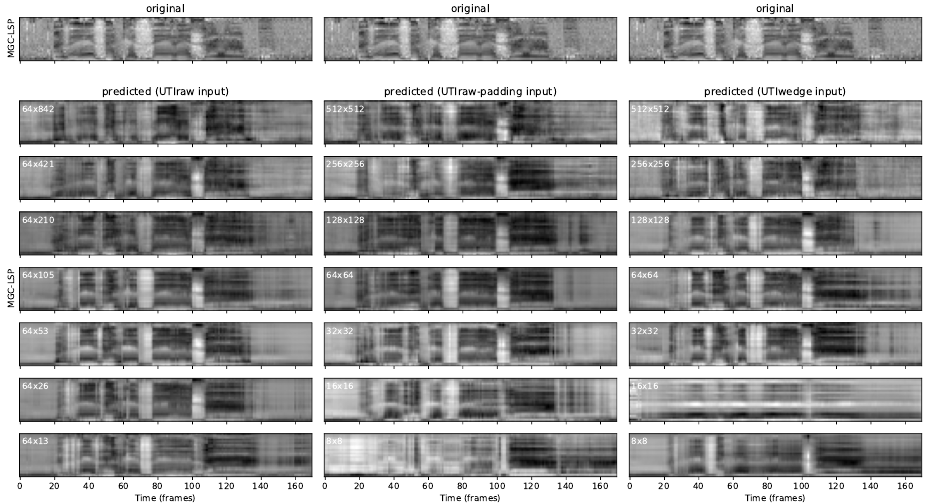
Figure 4. Demonstration samples: predicted MGC-LSP spectral features as a function of input image representation and size. Sentence: “Az Északi szél és a